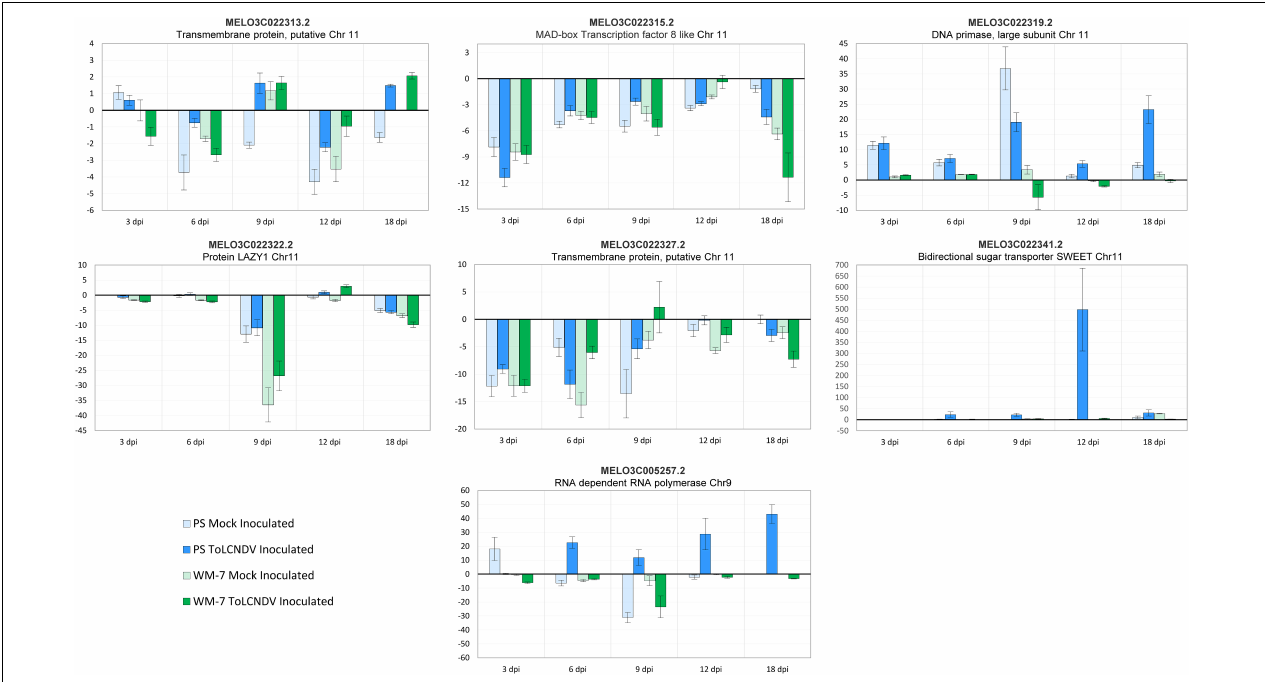
FIGURE 6 | Relative expression 2 ( − (cid:49)(cid:49) Ct ) of seven candidate genes for ToLCNDV resistance determined by qRT-PCR.